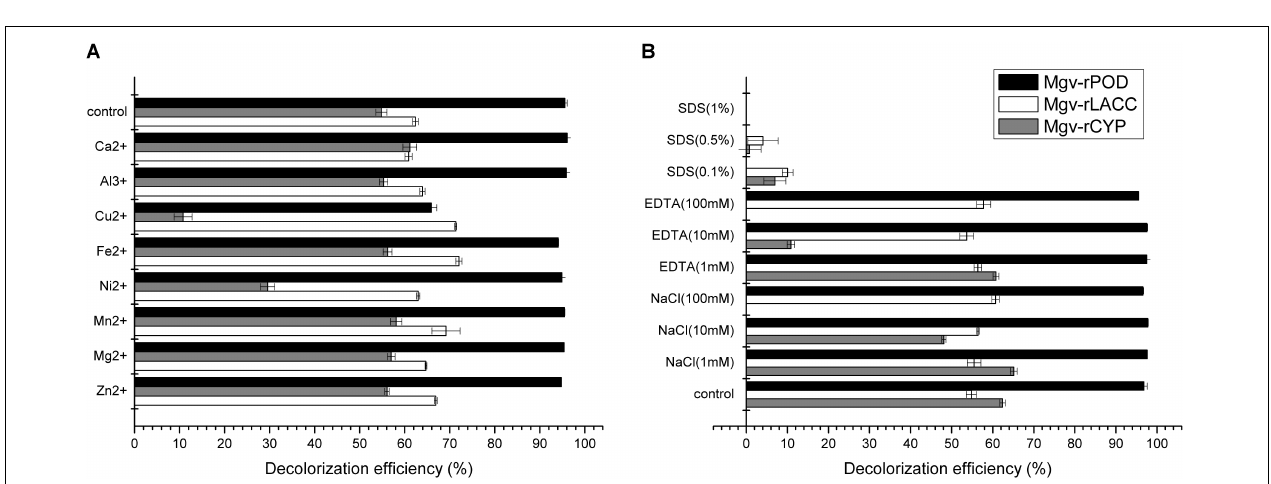
FIGURE 6 | The effect of metal ions (A) and potential inhibitors (B) on the MG decolorization efficiency of Mgv-rPOD, Mgv-rLACC, and Mgv-rCYP.